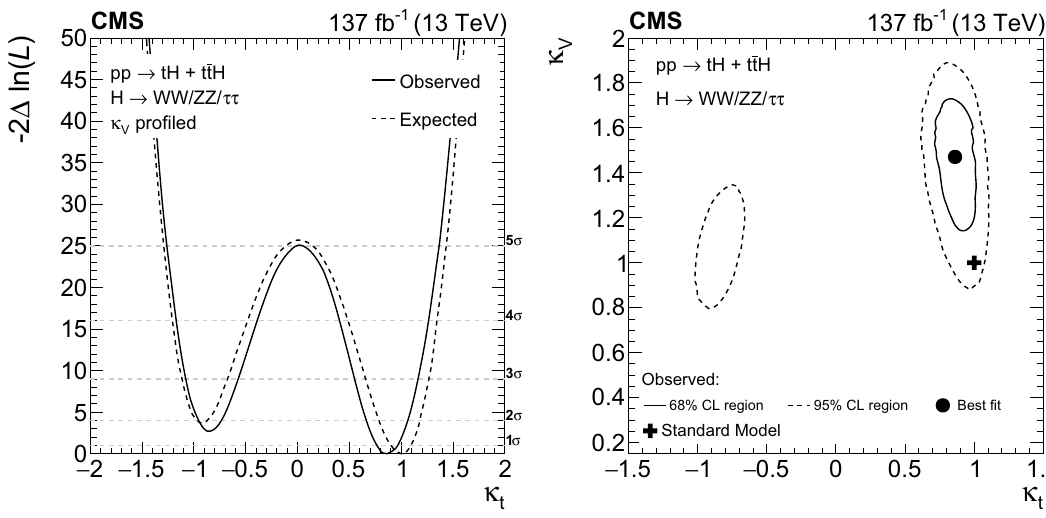
Fig. 17 Dependence of the likelihood function L in Eq. (3), as a function of κ t , profiling over κ V (left), and as a function of κ t and κ V (right)